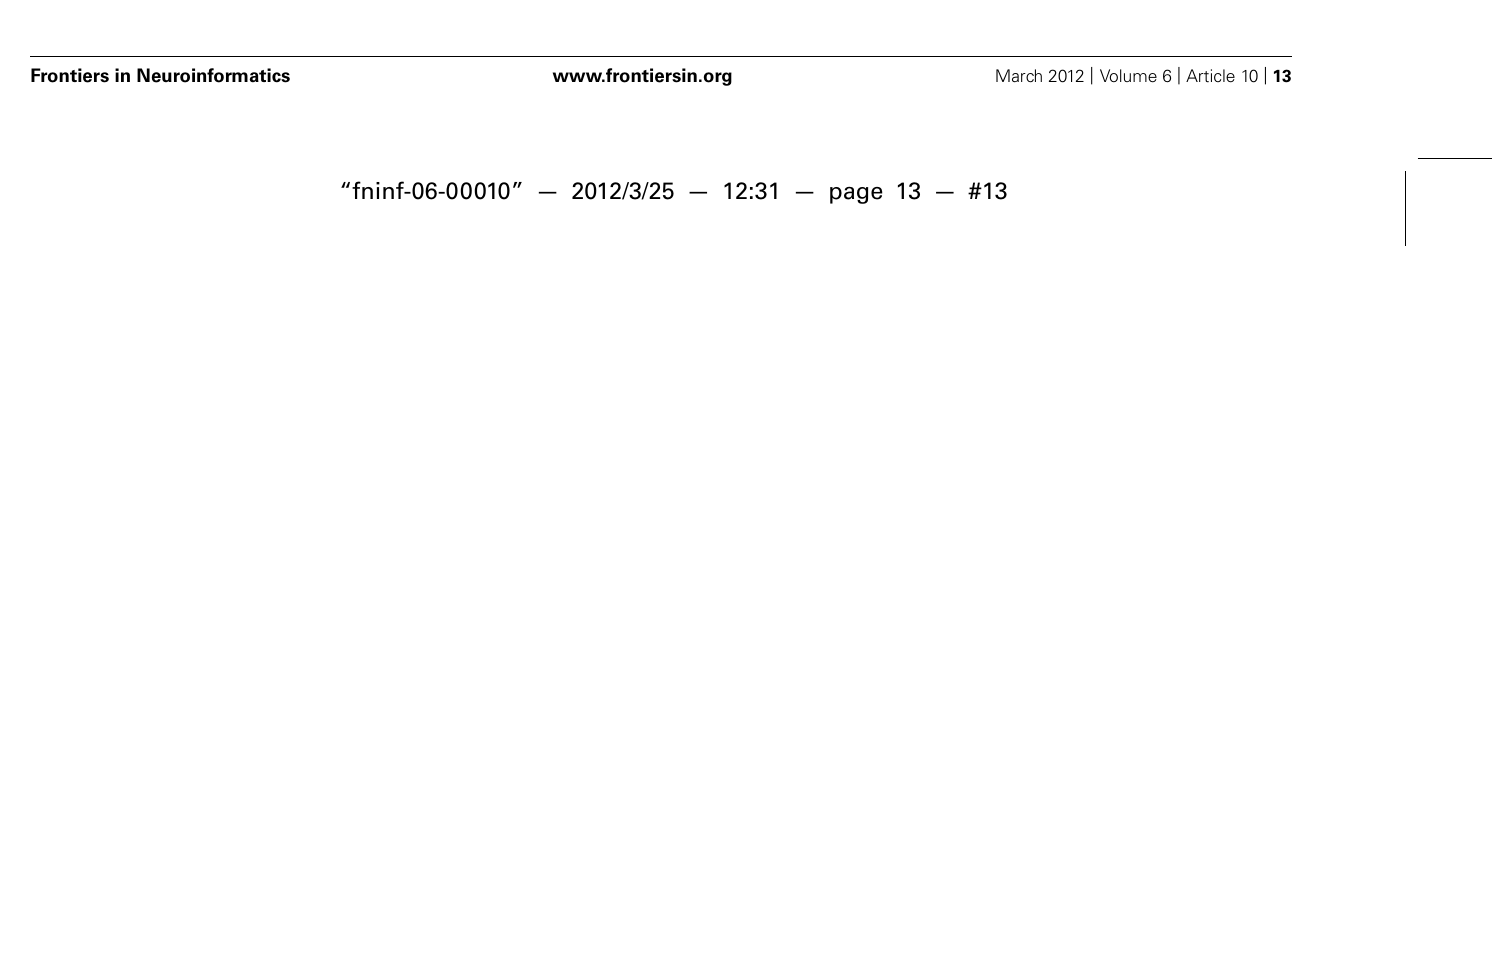
one-to-one correspondence to a rs-functional